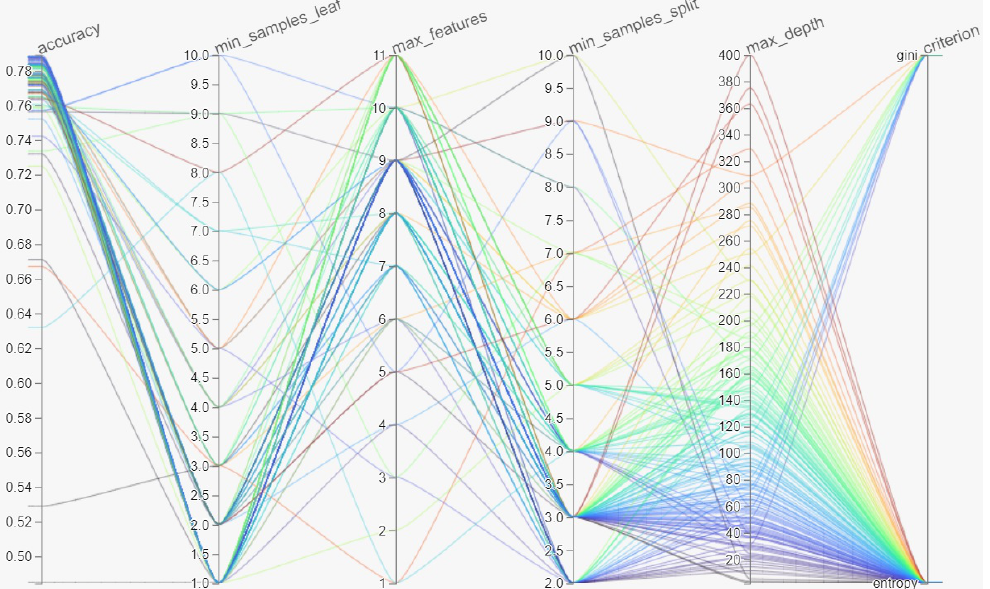
Figure 5. Visualisation of the hyperparameter optimisation procedure for the DT